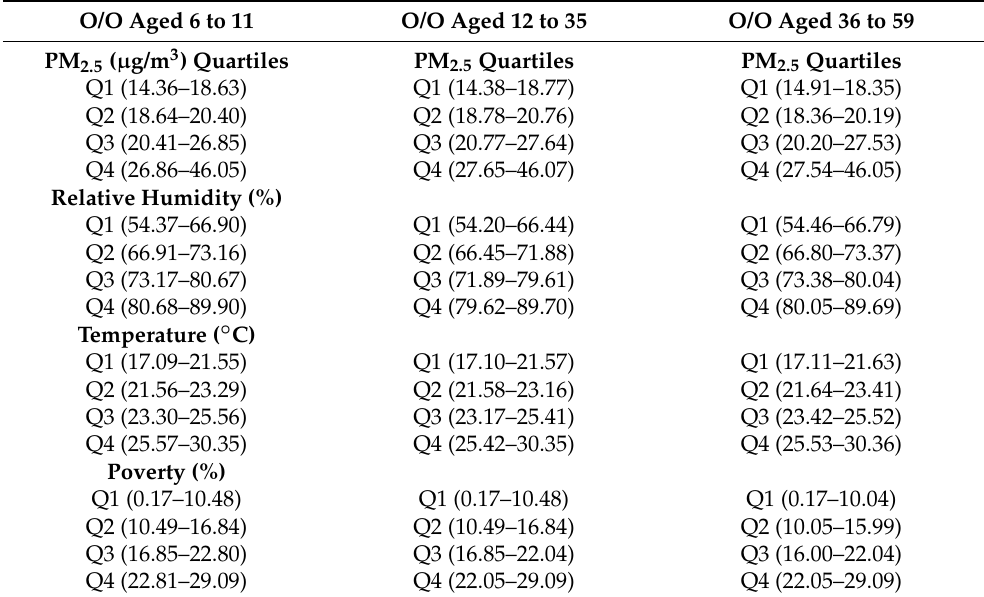
Table 1. Quartiles of poverty and environmental variables for a 6-month exposure window per